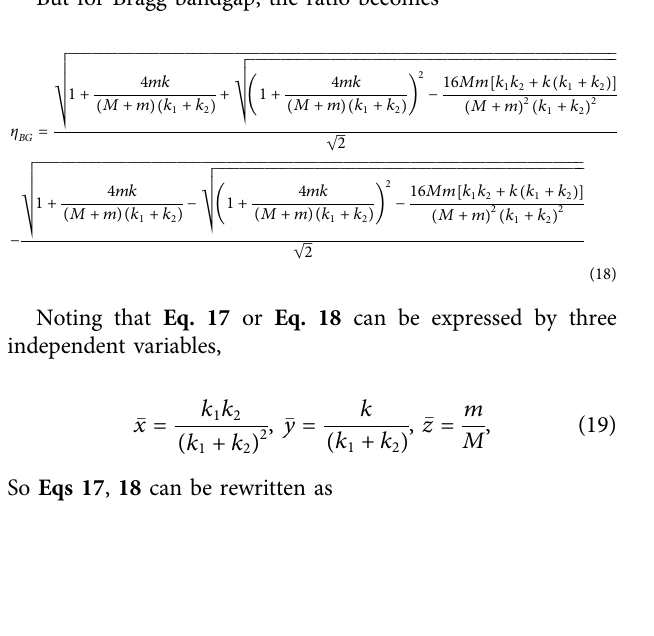
Frontiers in Materials |